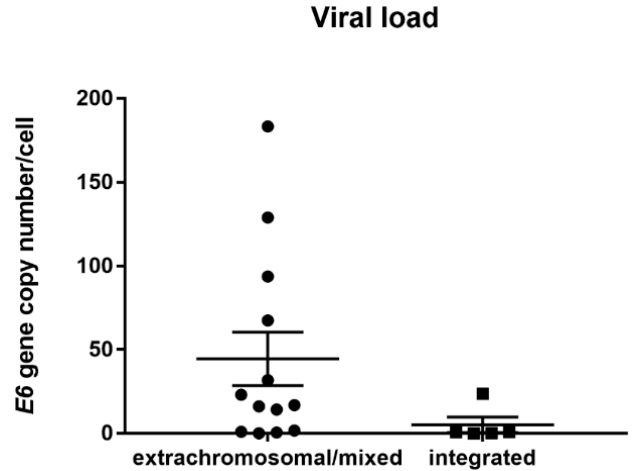
Figure 3. HPV16 viral load evaluation. Comparison of E6 gene copy numbers relative to RNase P copy number in tumors with extrachromosomal/mixed and integrated form of the viral genome. The difference was not statistically significant ( p = 0.075).